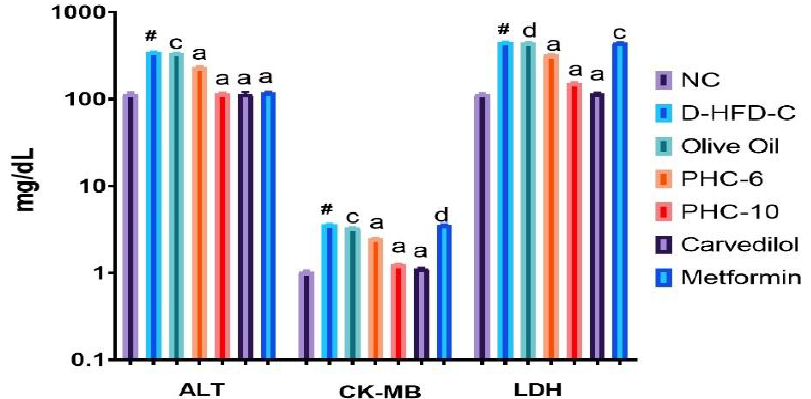
Figure 4. Cardiac biomarker enzymes. All values are expressed as mean ± SD ( n = 6) analyzed by one-way ANOVA followed by Tukey’s t -test. D-HFD-C was compared with NC ( # p < 0.0001), and the values were found to be highly significantly different. The different treatment groups were compared with the D-HFD-C group, with the values expressed in log 10 scale on the Y-axis, and the results for each parameter (ALT, CK-MB and LDH) were found to be different at the following significance levels: d p < 0.05; c p < 0.01; a p < 0.0001 from the respective disease control groups. NC is normal control; D-HFD-C is diabetic high-fat diet control group; PHC6 and PHC10 are polyherbal combination treated groups.